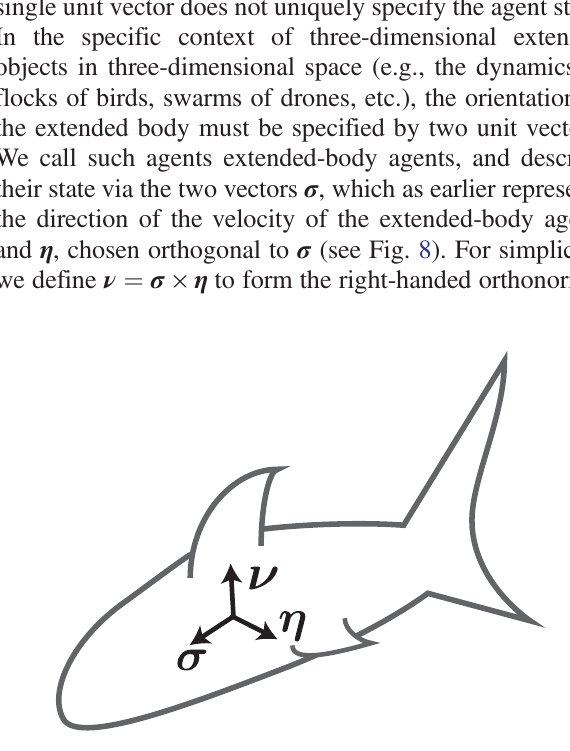
FIG. 8. Illustration of an extended-body agent. Unlike the agents in the generalized Kuramoto model Eq. (2), we assume that the state of an extended-body agent cannot be described by a single unit vector σ . Rather, the pair of vectors σ and η together describe the orientation and state of the agent. The direction of agent velocity is assumed to be along the direction σ as earlier. The unit vector ν is defined as ν ¼ σ × η